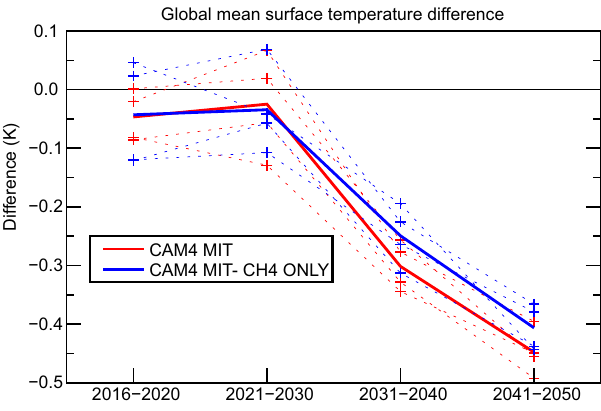
Figure 18. Time evolution of differences in global-mean surface temperature between transient simulations following the mitigation (MIT) and the current legislation (CLE) scenario (i.e. MIT–CLE), as simulated by the CESM–CAM4 model with a slab-ocean repre- sentation. One experiment (red lines) included all emission reduc- tions of the MIT scenario, whereas another experiment (blue lines) included only the CH 4 emission reductions of the MIT scenario. Ensemble mean results are shown with thick lines, individual en- semble members with thin lines.